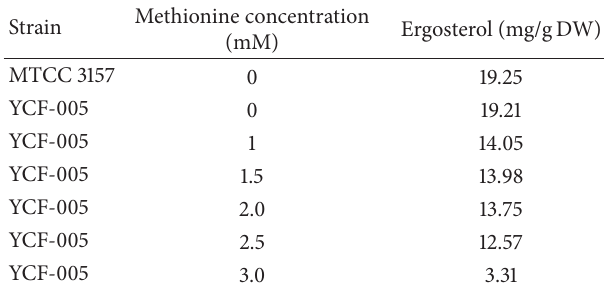
Table 3: The final ergosterol content with varying concentrations of methionine (average data obtained from triplicate of the experi- ments were